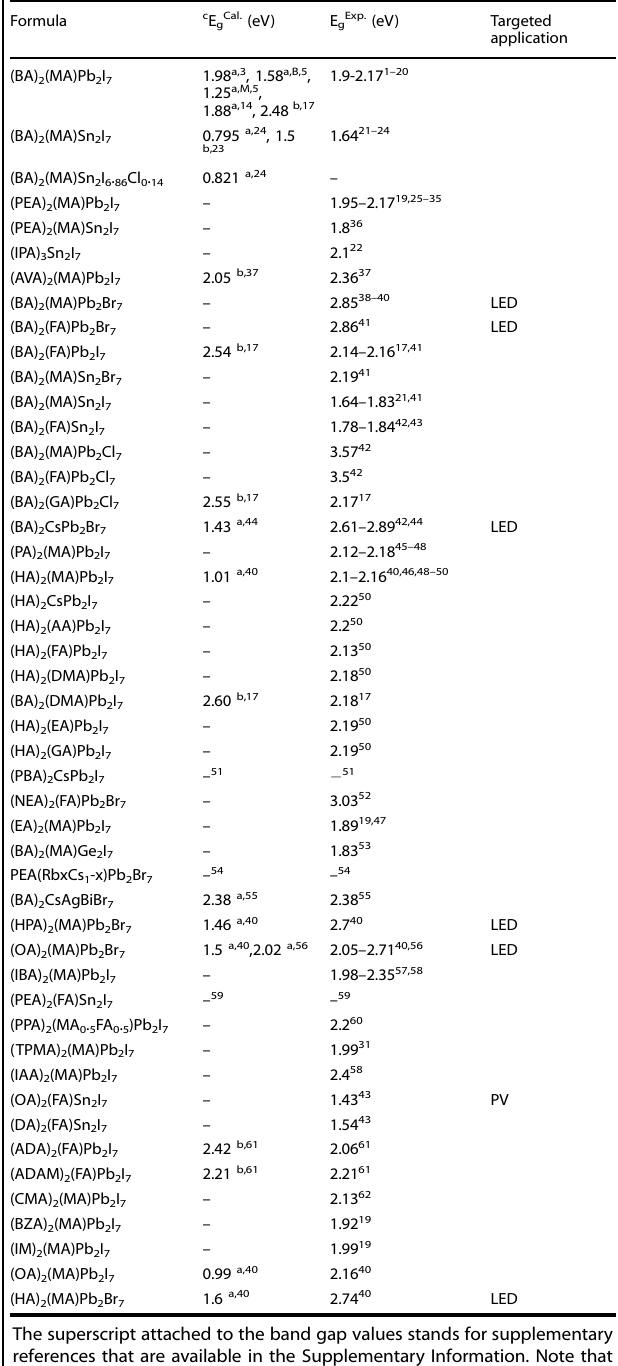
Table 2. Details for well-known existing HOIPs based on an RP structure with n =